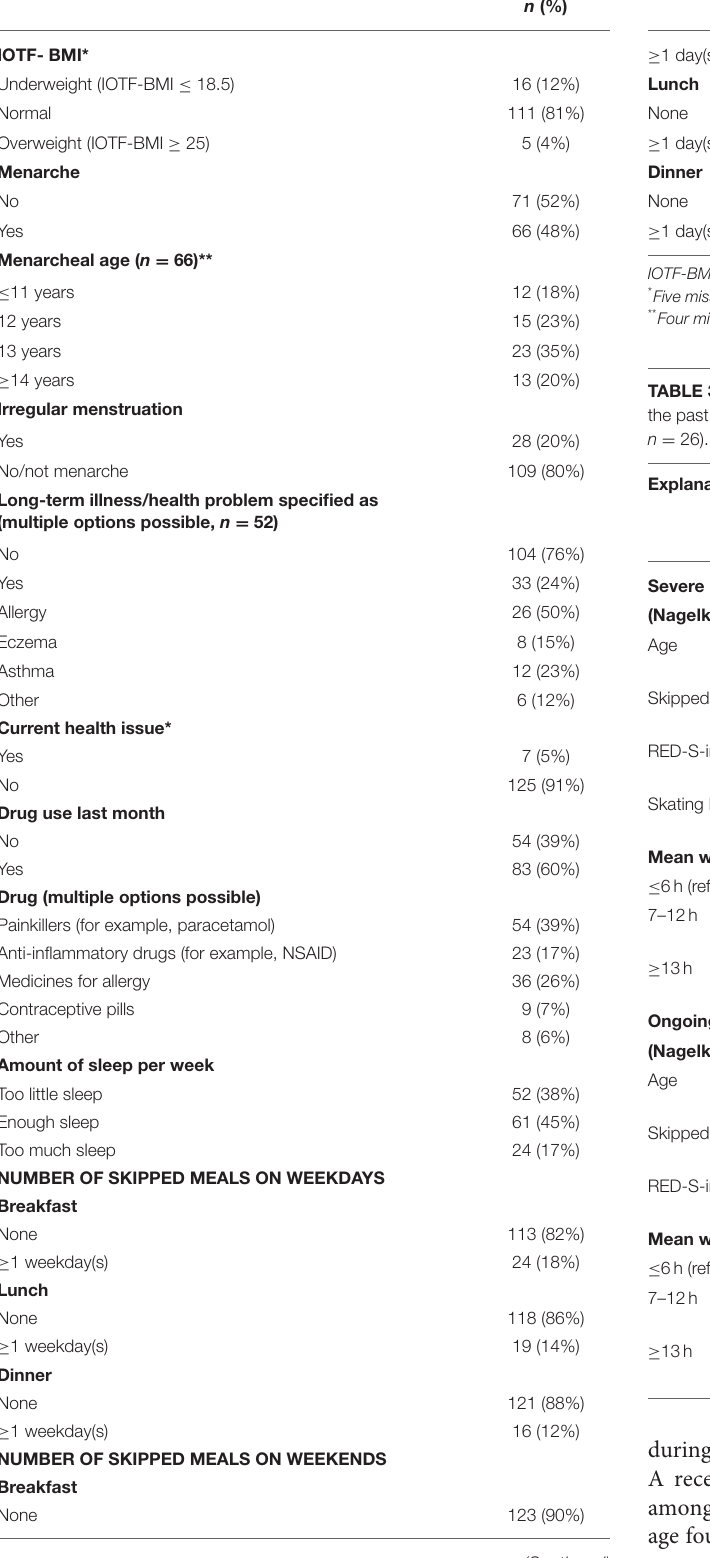
among 294 American figure skaters between 9 and 19 years of age found that 69% of the injuries were due to overuse and